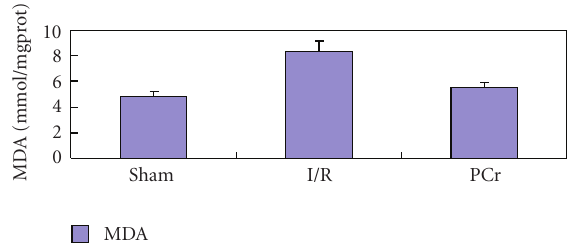
Figure 5: MDA content (nmol · L − 1 ) was detected with MDA kit; protein content (mg · L − 1 ) in corresponding tissue was detected with Coomassie brilliant blue protein assay kit. MDA content in the tissue was calculated using the following formula: MDA (nmol · mgprot − 1 ) = MDA content (nmol · L − 1 )/protein content (mg · L − 1 ) in corresponding tissue ×